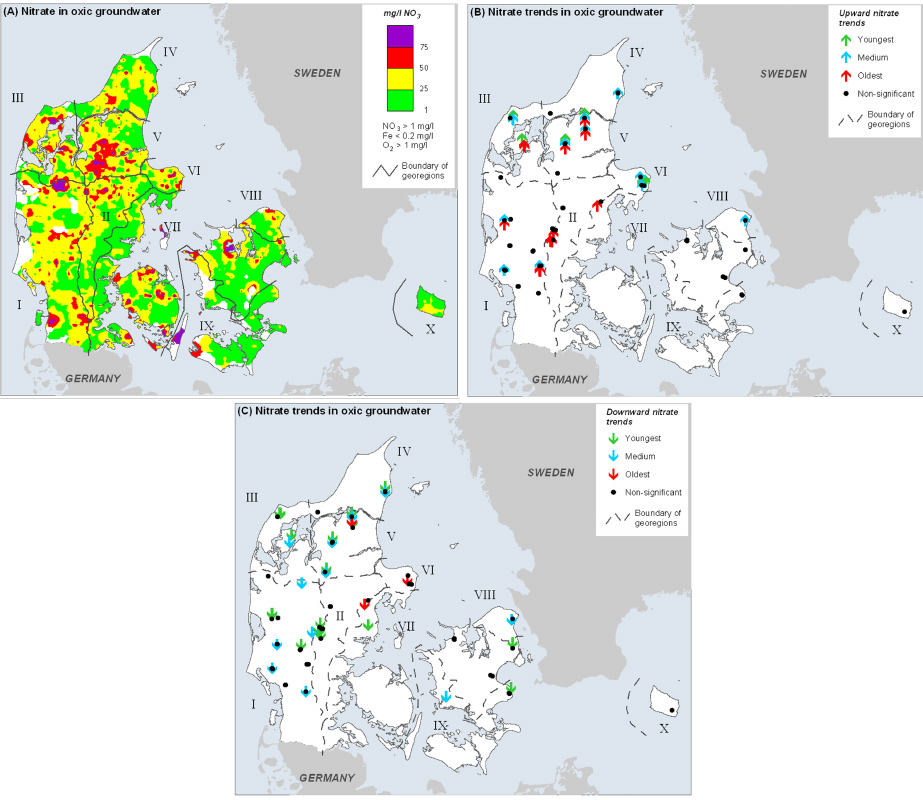
Fig. 2. (A) Interpolated geographic distribution of nitrate concentrations in oxic groundwater in Denmark based on 3757 analyses performed from 1890 to 2010. Average values from each measuring point are used in the interpolation. Shown are also 10 different geo-regions. (B, C) Geographic distribution of nitrate trends determined in 152 oxic CFC-dated groundwater monitoring points sampled from 1988 to 2009. A downward nitrate trend represents a negative slope of the linear regression line of nitrate versus sampling year for each groundwater monitoring point, while an upward trend shows a positive slope. The upward and downward nitrate trends are statistically significant with a 95% confidence level. Statistically non-significant nitrate trends are also